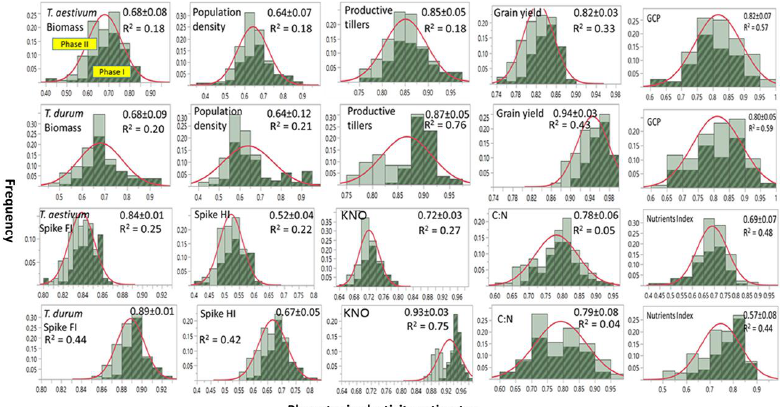
Figure 1. Frequency distribution (y-axis), range, and mean ± SD of phenotypic plasticities (x-axis) of agronomic traits and micronutrients index estimated on two genotypes representing T. durum and T. aestivum and then subjected to two stress phases, each of three years.